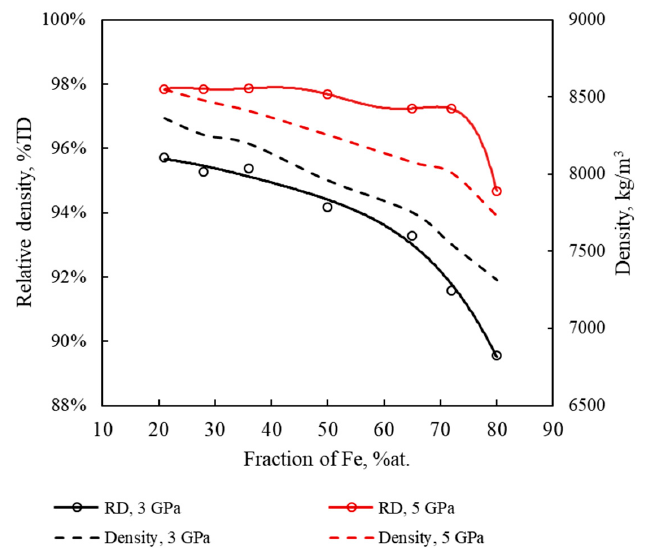
Figure 3. The relative (solid lines) and absolute (dashed lines) density of Fe–Cu samples cold sintered at 3 GPa (black lines) and 5 GPa (red lines) as a function of Fe content.